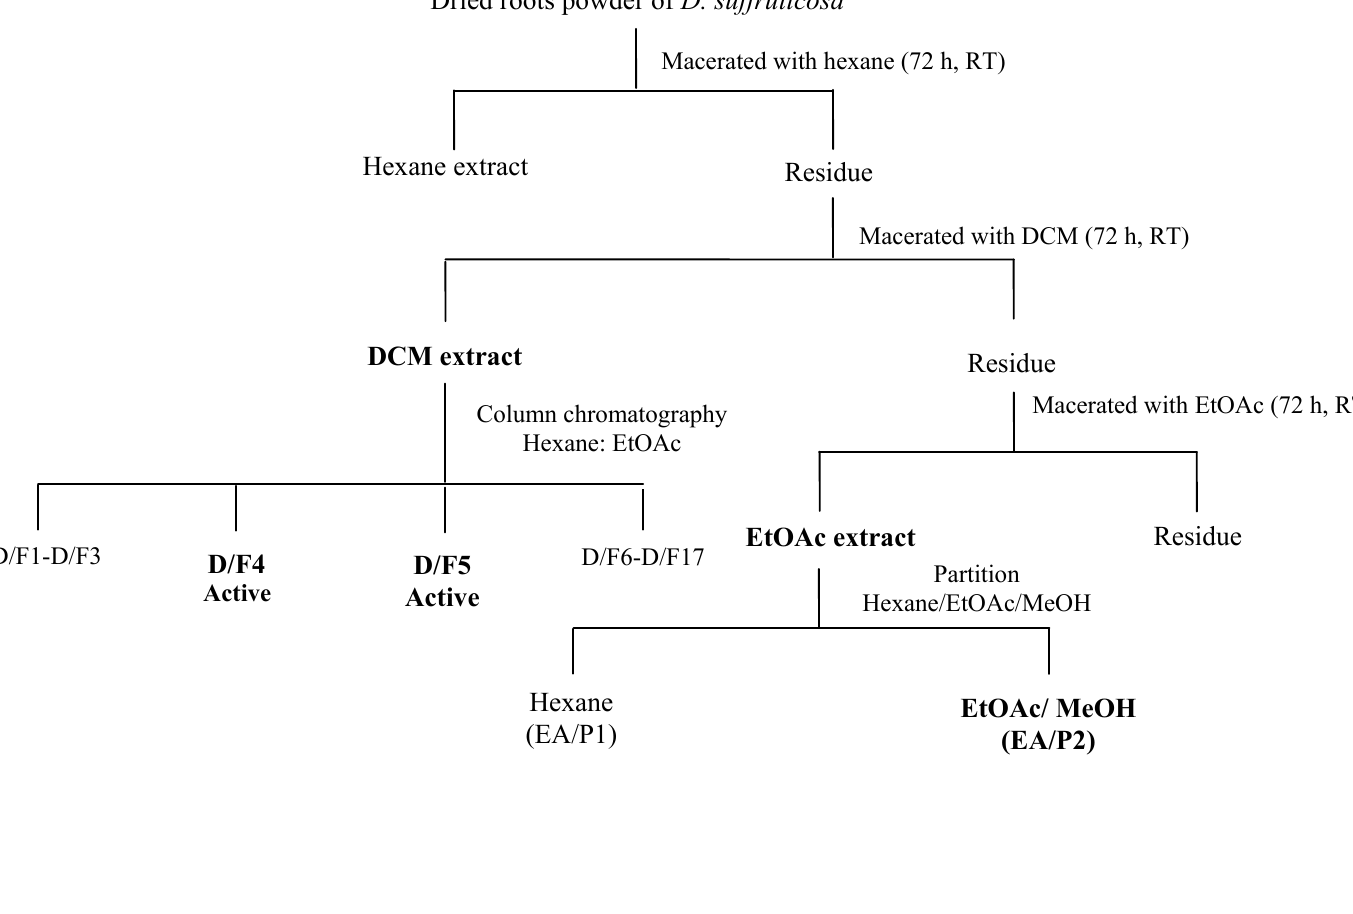
Figure 5. Chromatographic fractionation of DCM and EtOAc extract of D. suffruticosa roots. D/F4 and D/F5 represent the active fractions obtained from fractionation of DCM extract using hexane: EtOAc gradient as mobile phase. EA/P2 represents the active fraction obtained from fractionation of EtOAc extract using hexane: EtOAc: MeOH as mobile